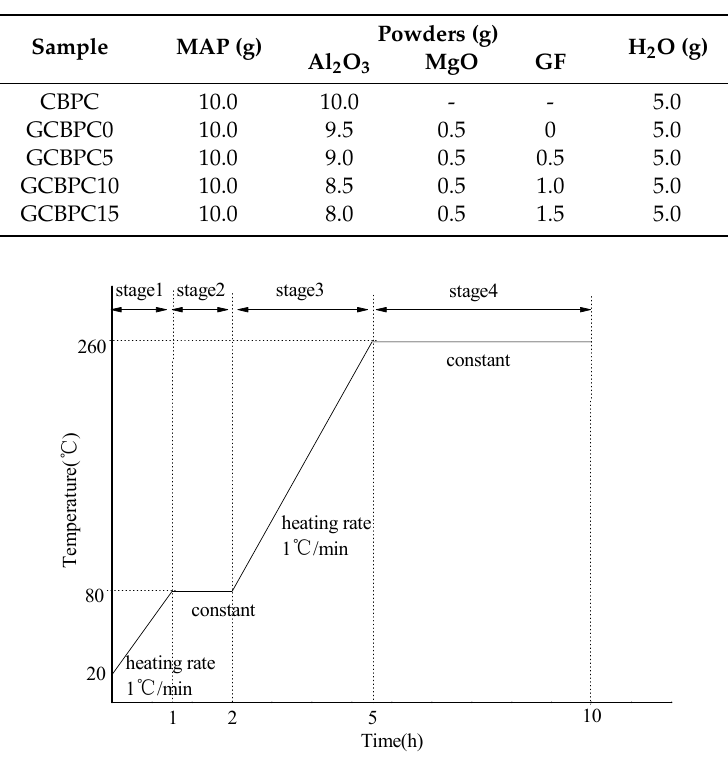
Figure 1. Curing process of phosphate ceramic coatings.